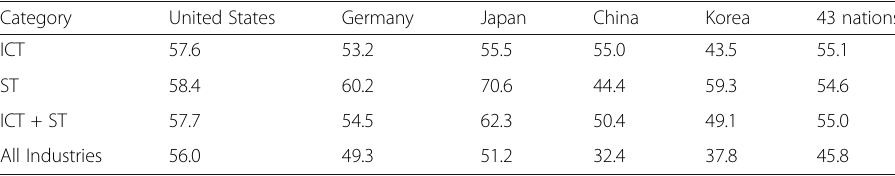
Table 2 Value-Added Ratio of the ICT -and ST Sectors of Global Major Powers(%)